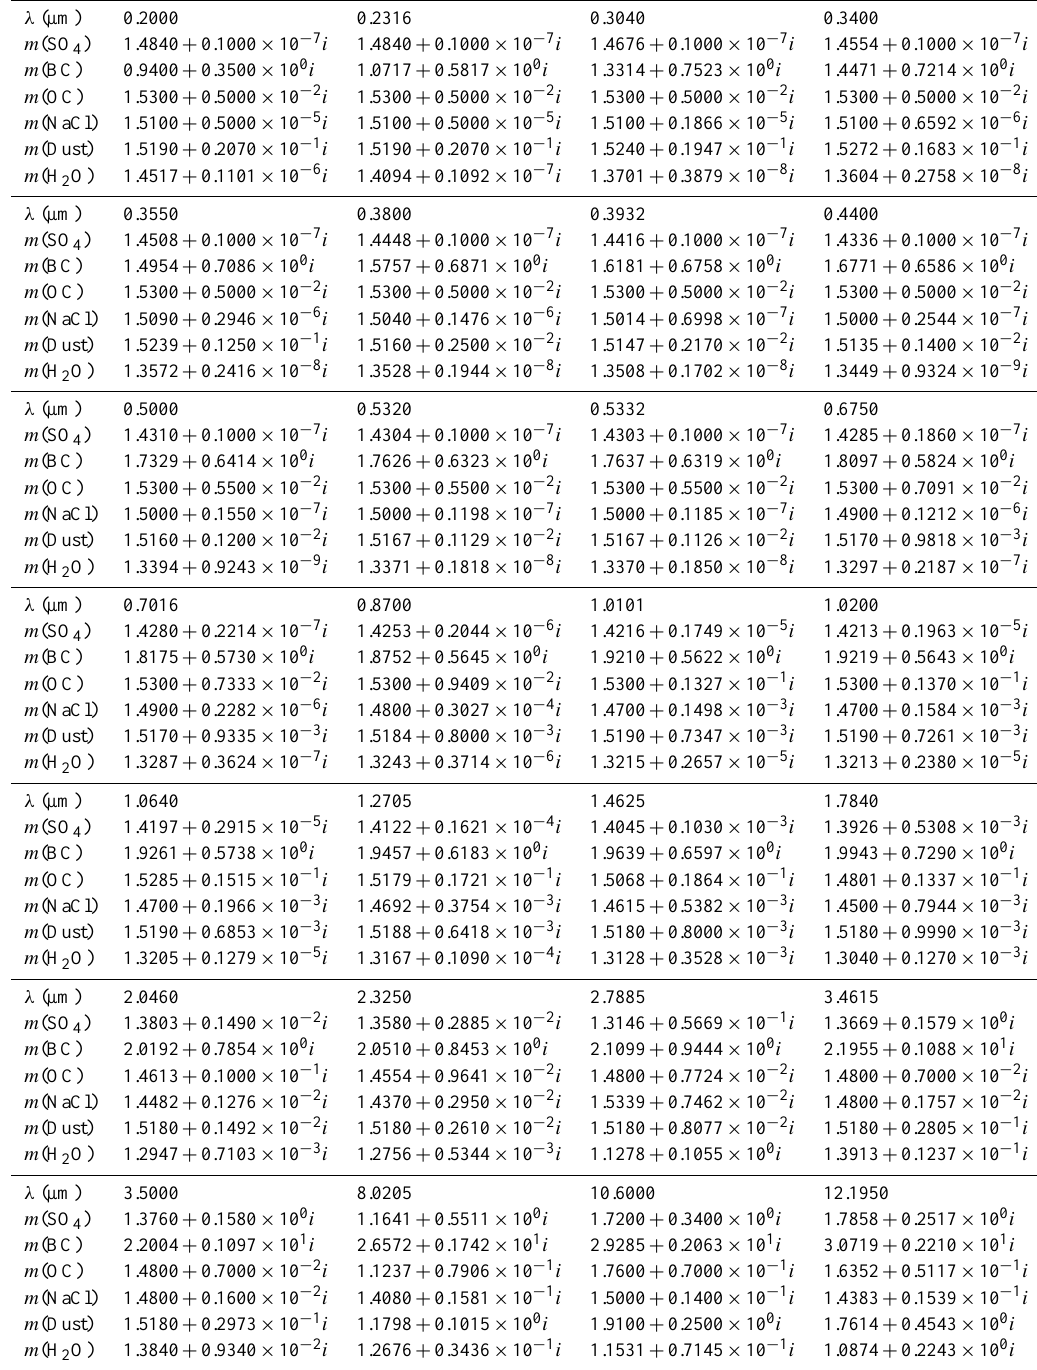
Table D1. Refractive index m for each wavelength in the aerosol-optics look-up table and for various aerosol